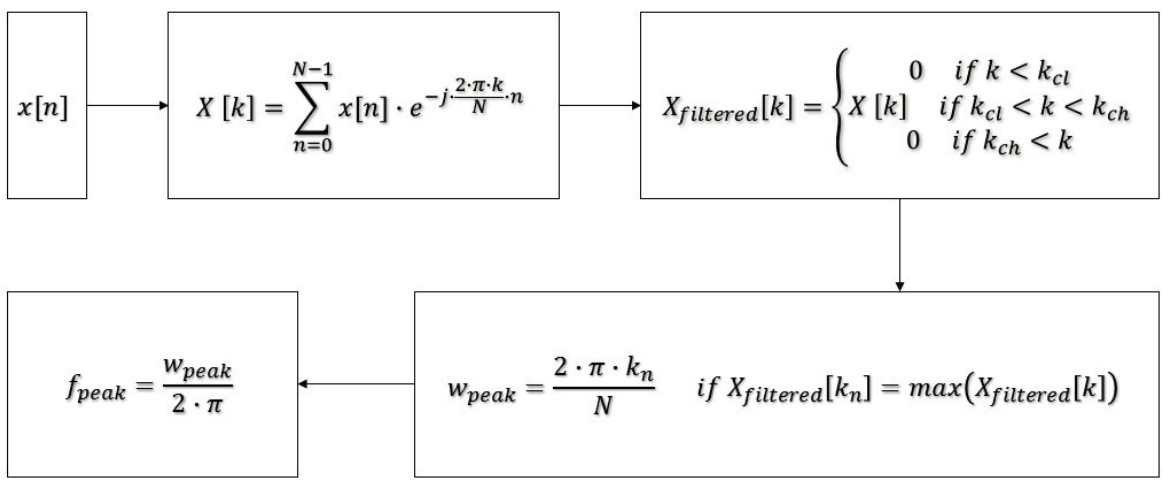
Figure 3. Digital signal processing operations applied on the